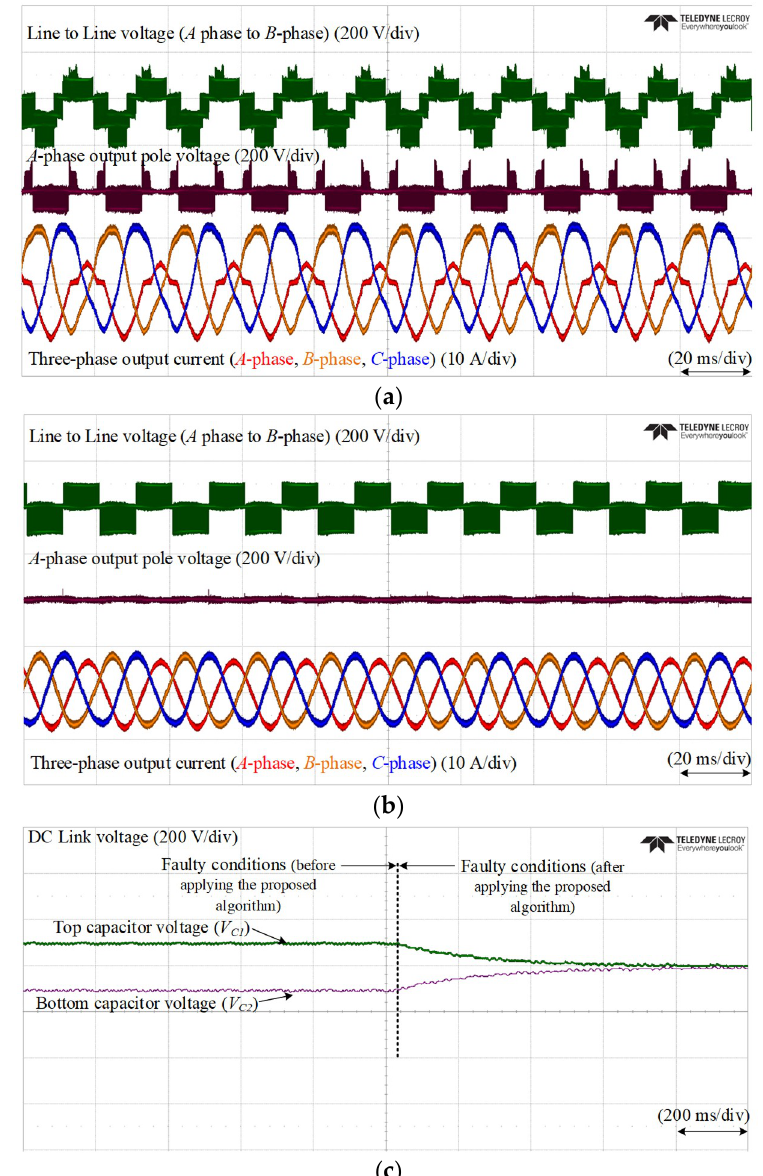
Figure 15. Experimental results for V ab , V an , and three-phase currents when an open-circuit failure occurs at Q a1 / D Qa1 at ( a ) faulty conditions (before applying the proposed method), ( b ) faulty conditions (after applying the proposed method), and ( c ) top and bottom capacitors voltages before and after applying the proposed method.